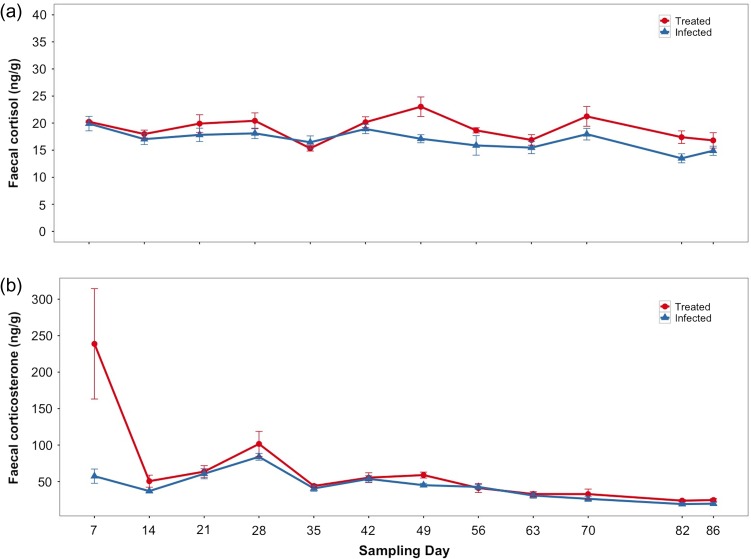
Reindeer infected with Ostertagia gruehneri (blue triangles and blue lines) had lower faecal cortisol (a) and faecal corticosterone (b) than treated reindeer (not infected with O. gruehneri; red circles and red lines). Glucocorticoid values (in nanograms per gram) are represented here as a mean value (±SEM) for each sampling day.